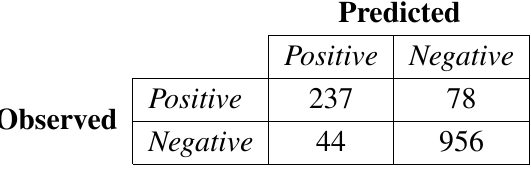
Table 2. Confusion matrix of nest detection after tracking and limited evaluation distance (four